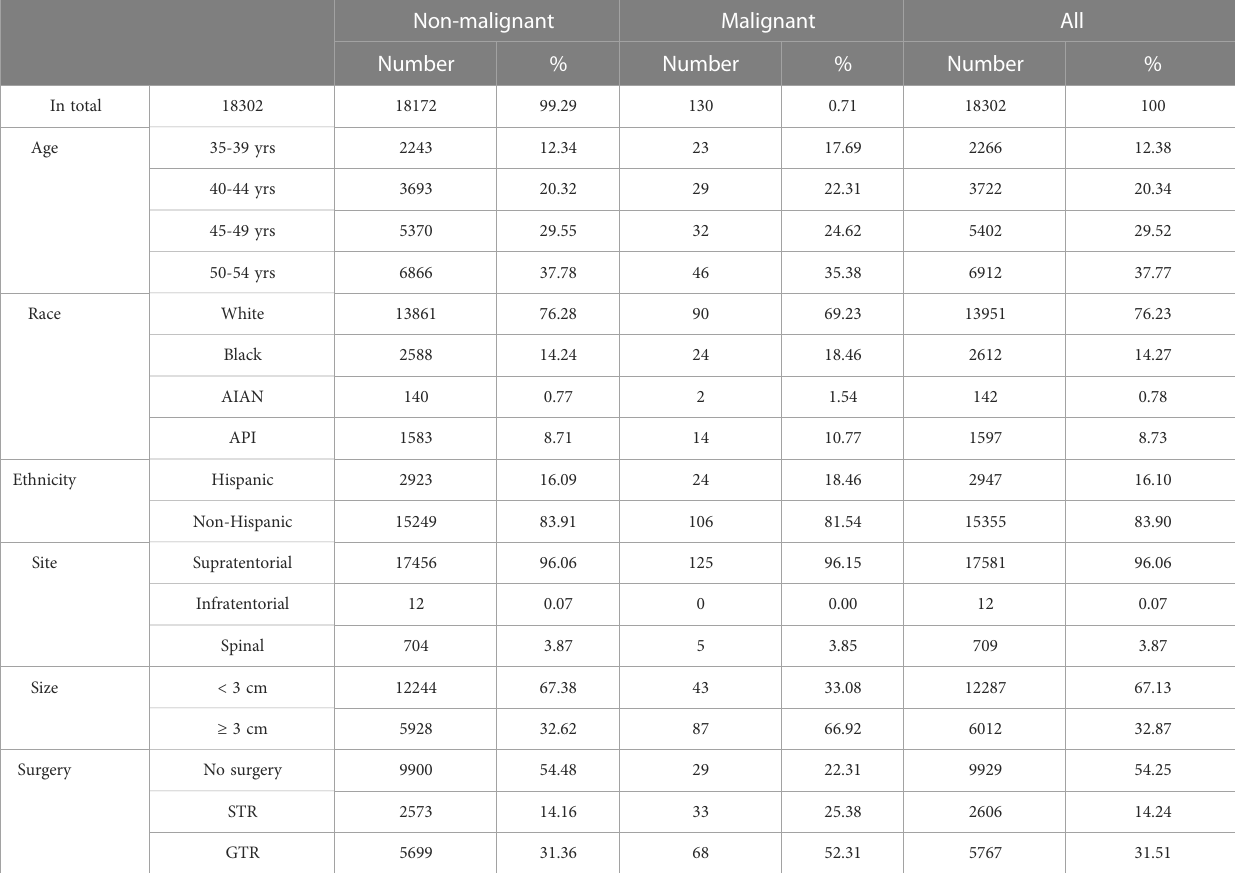
TABLE 1 Patient baseline